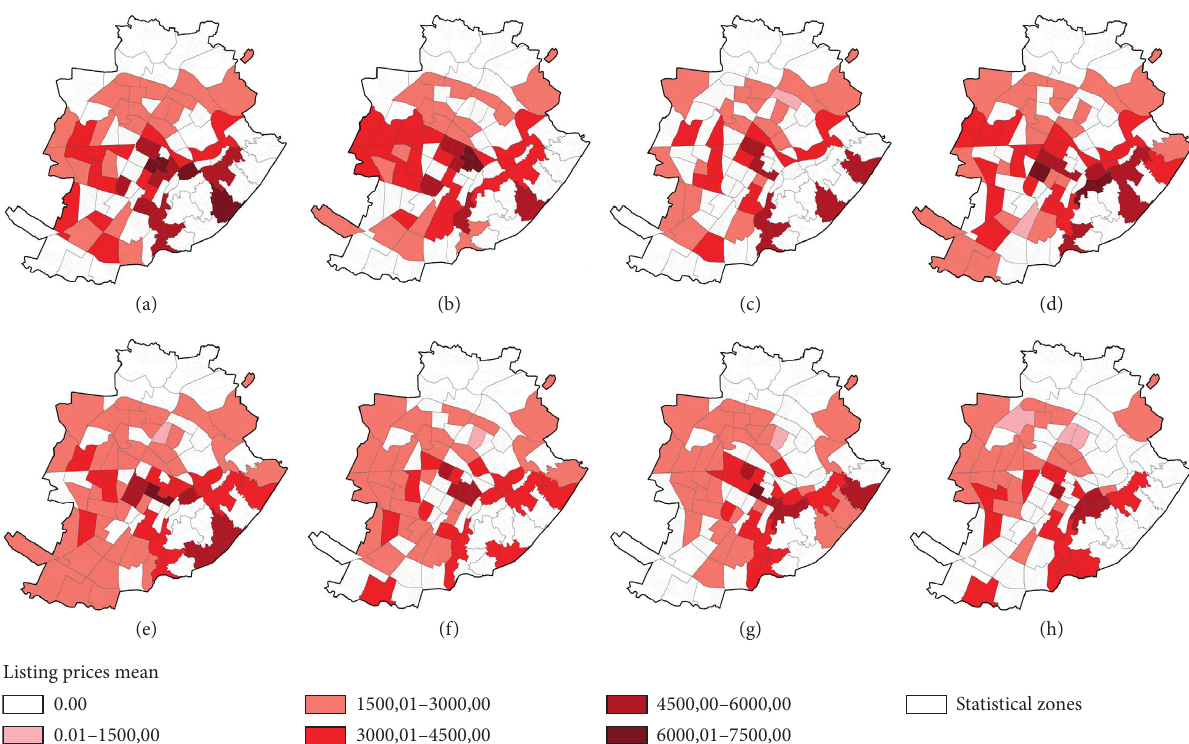
Figure 5: Construction sites mean listing prices of new housing stock (NLP) (source: author’s elaboration). (a) 2011. (b) 2012. (c) 2013.